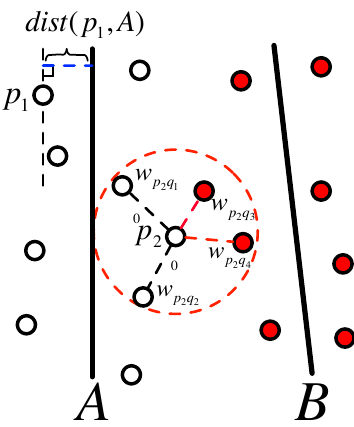
Figure 5. An illustration of labeling points and their fitting planes. The white dots and red dots represent the points with different labels assigned to plane A and plane B, respectively. The distances between points and planes are perpendicular distances. The points in the red circle illustrate the neighboring points of p 2 and the smoothness cost to the different points.